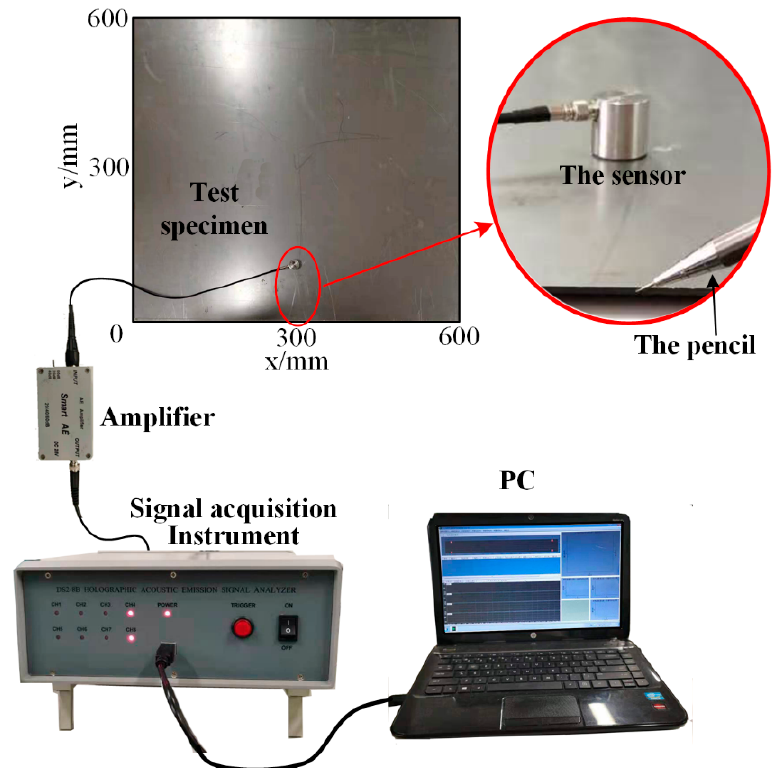
Figure 7. Experimental setup.